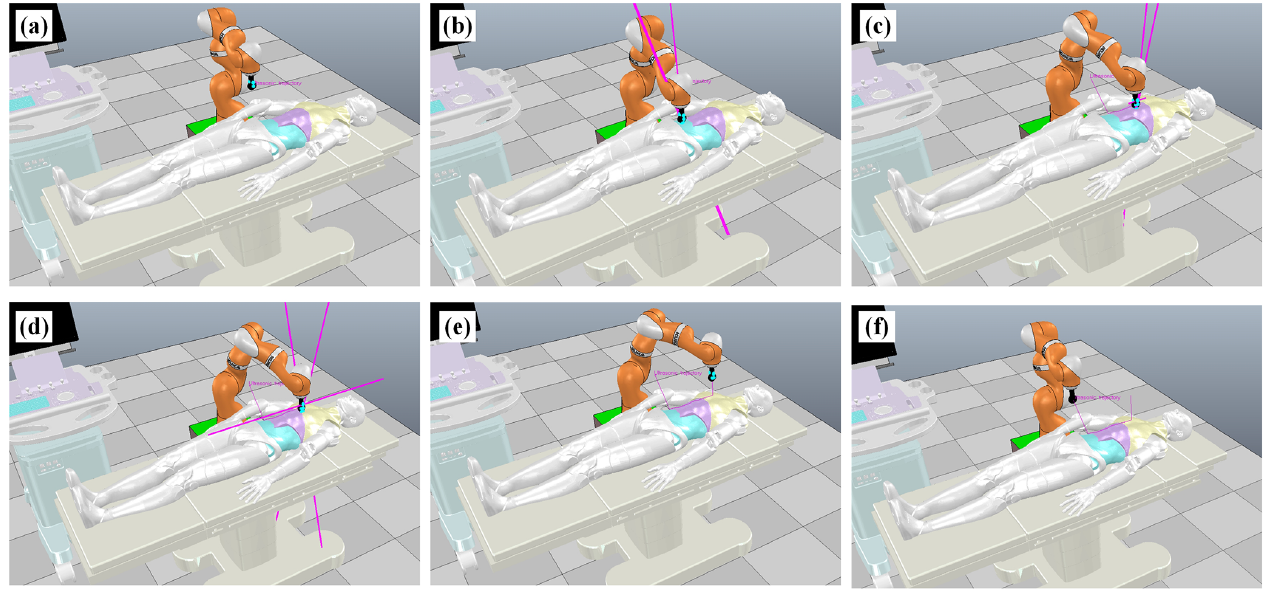
Figure 12. Validation results of the KUKA LWR during the scanning process of the straight line trajectory. (a) Initial position of the US probe. (b) The abdomen (soft). (c) The belly (middle stiffness). (d) The chest (hard). (e) Leaving the patient. (f) Final position of the US probe.